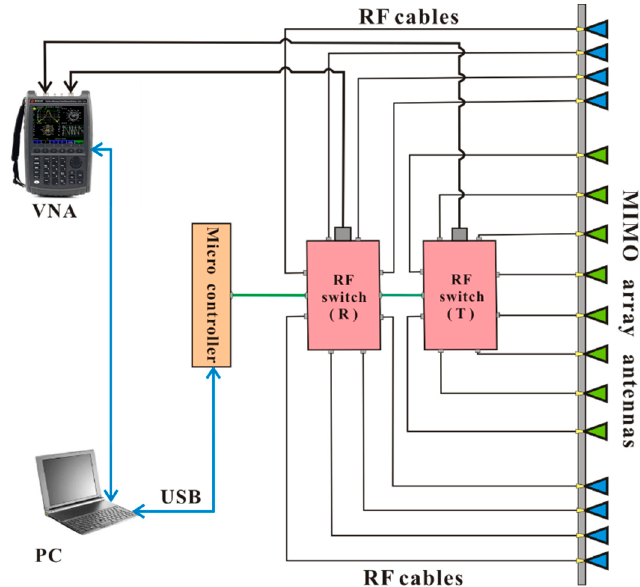
Figure 1. Block diagram of the designed ultra-wideband multi-input multi-output (UWB MIMO) radar system.